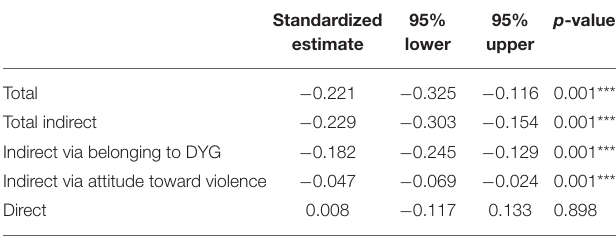
TABLE 8 | Results of the mediation